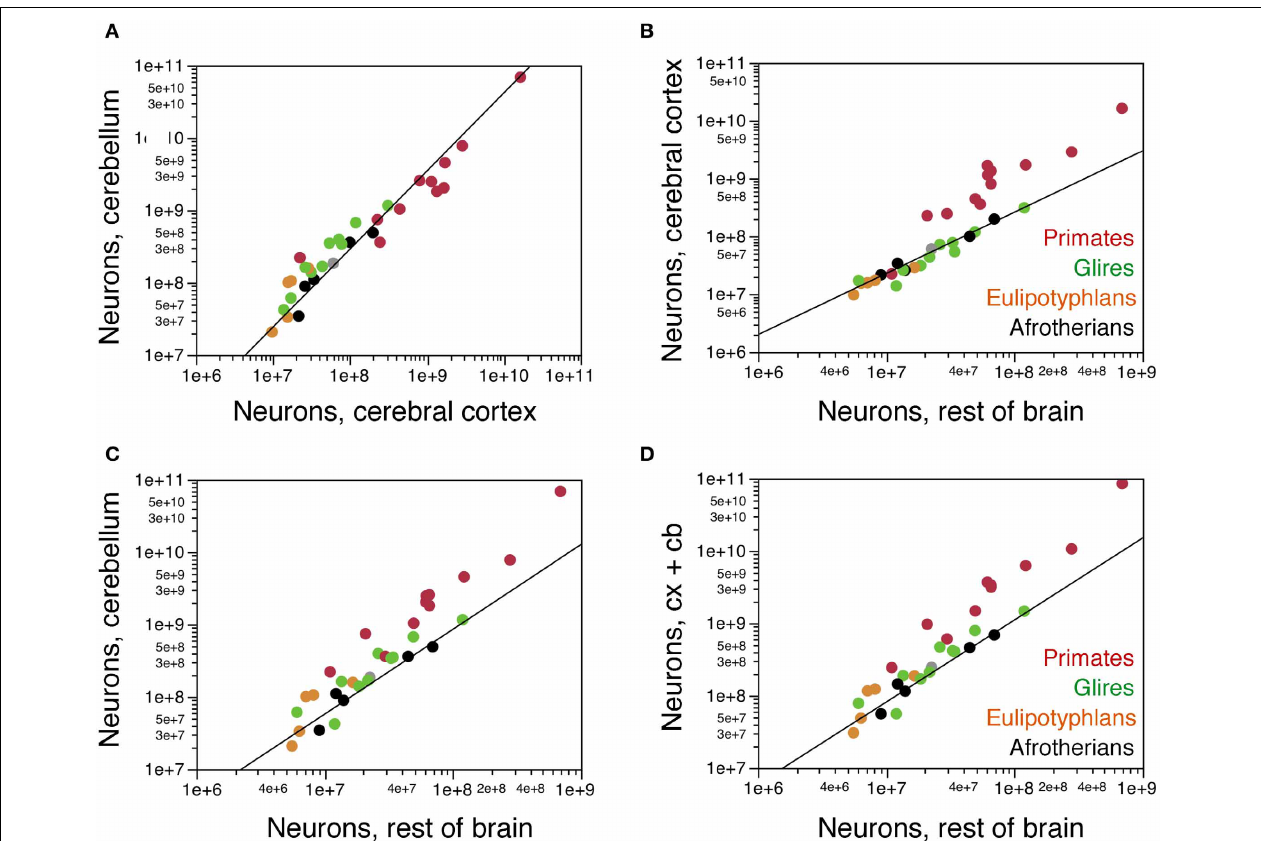
FIGURE 6 | Covariation in numbers of neurons in brain structures across species. (A) Numbers of neurons in the cerebellum vary as a common power function of numbers of neurons in the cerebral cortex of exponent 1.079 ± 0.200 (plotted), or as a linear function of slope 4.164 ± 0.088, that is shared by afrotherians, Glires, eulipotyphlans, and primates. (B) Numbers of neurons in the cerebral cortex vary as a common function of numbers of neurons in the rest of brain that is shared by afrotherians, Glires, and eulipotyphlans, but not